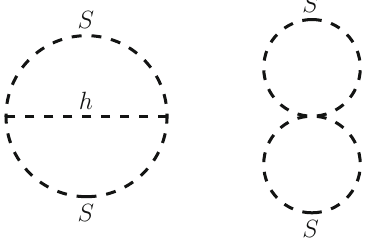
Fig. 6 Dominanttwo-loopdiagramscontributingtotheHSMeffective